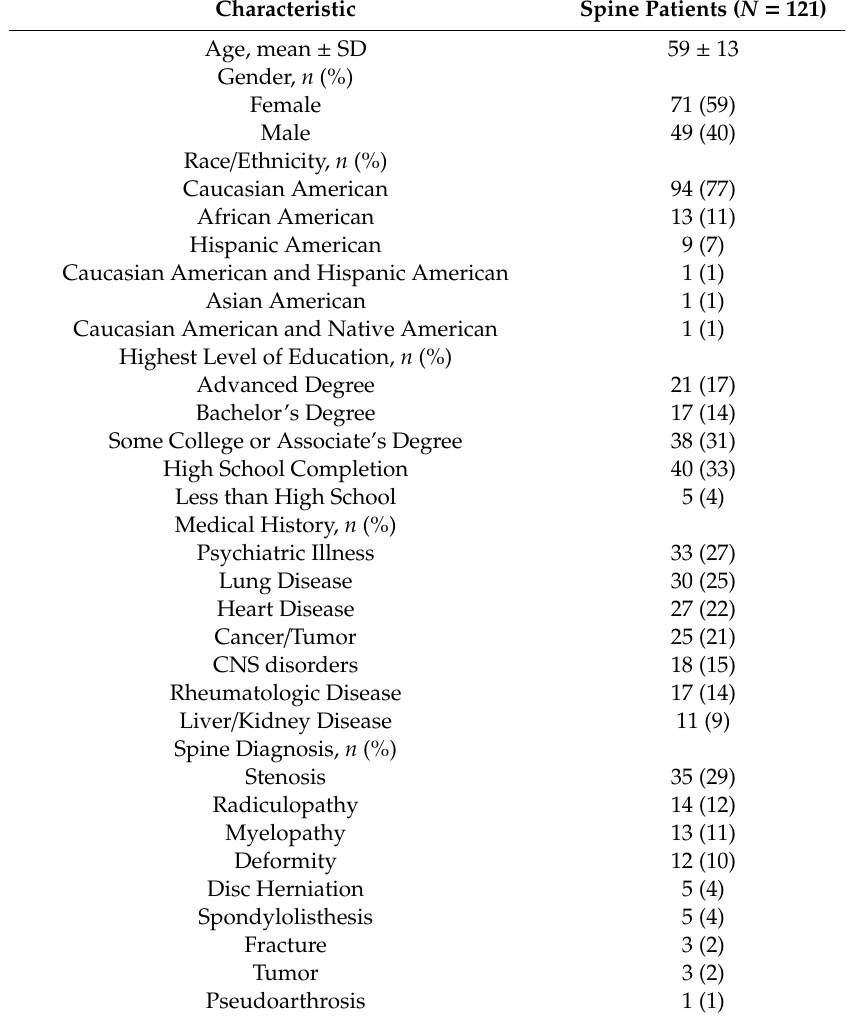
Table 1. Demographic and clinical characteristics of survey